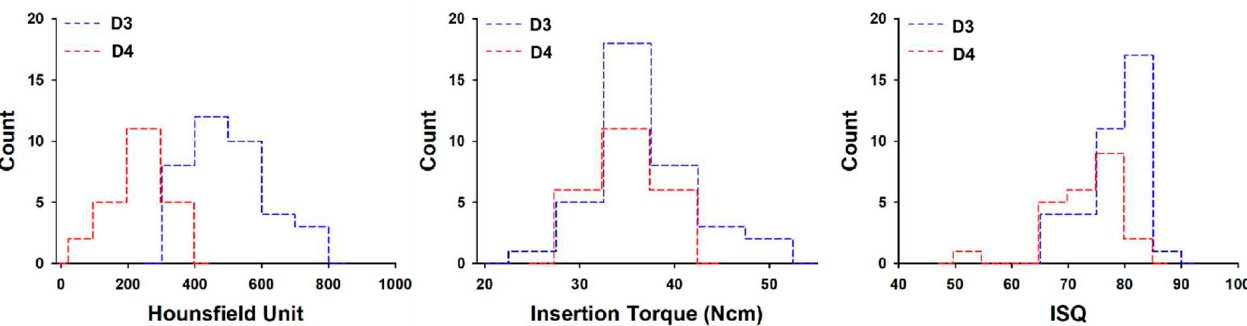
Figure 5. Histogram of average Hounsfield units, maximum insertion torque, and implant stability quotient values with type of bone. ISQ = implant stability quotient.